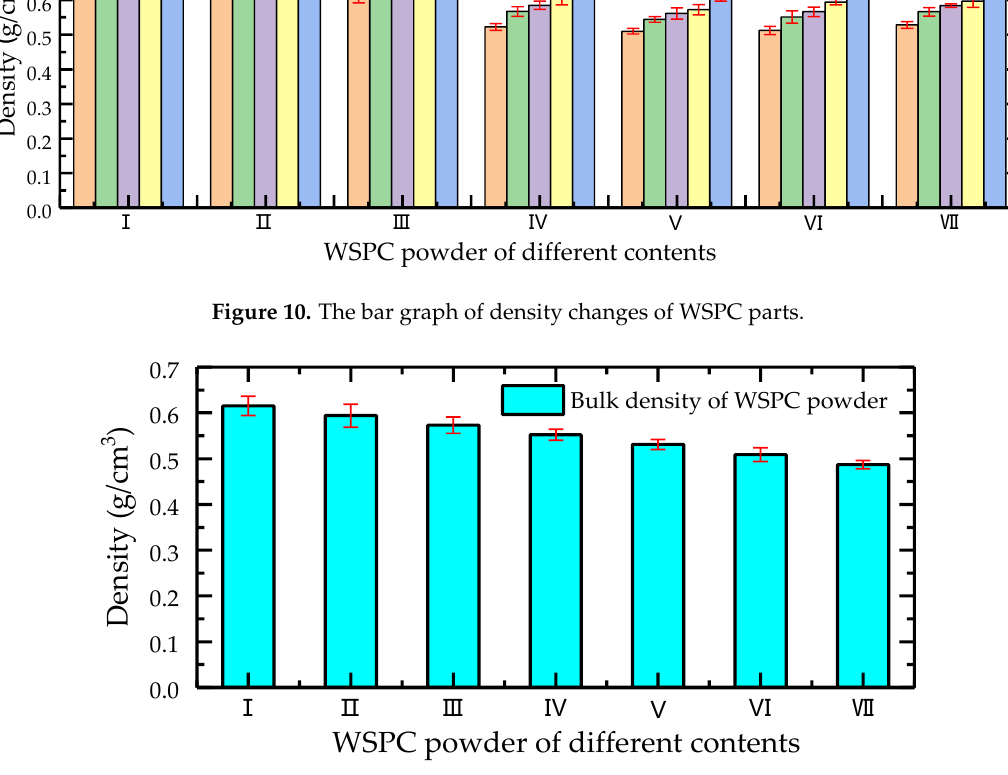
Figure 11. The bulk density of WSPC powder with different polymer powder contents.